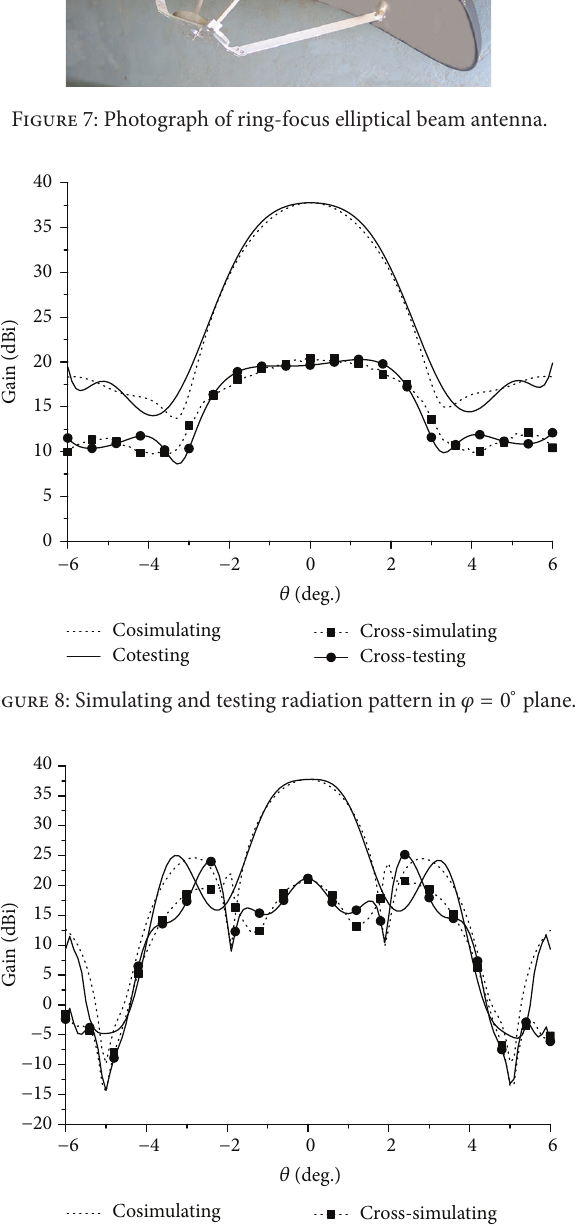
(PSLL) in 𝜑 = 90 ∘ plane is − 10.3 dB, relatively high when it